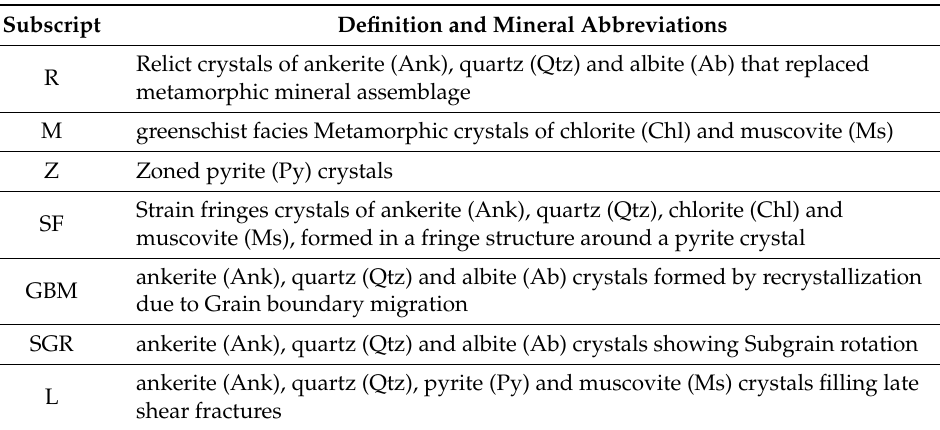
Table 1. Subscript definition and mineral